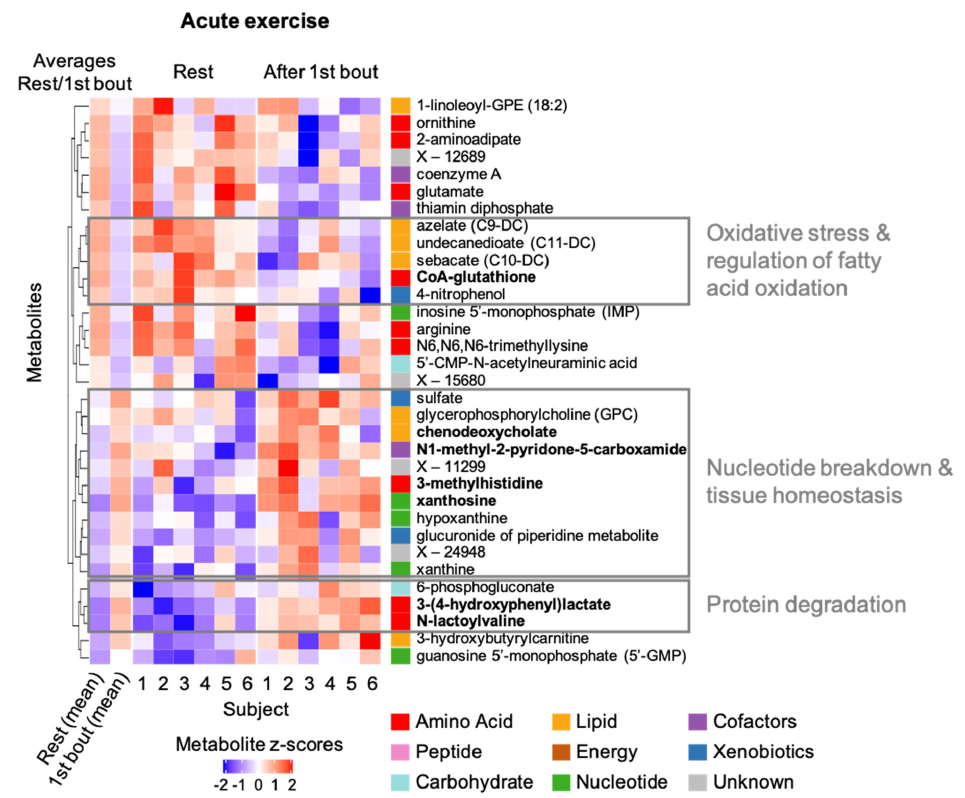
Figure 4. Heatmap of metabolites changing in response to acute exercise. Individual and average metabolite levels at rest and after the first bout of exercise are shown as z ‐ scores for all 33 metabolites with changes in response to acute exercise ( p < 0.05); red color indicates higher levels compared to all levels measured for the specific metabolite in the present study; analogously, blue color indicates lower levels; names of metabolites with significant changes after correcting for multiple testing are shown in bold. Metabolites were clustered by their similarity in metabolite levels at the two conditions across the participants; the resulting clusters are displayed in the dendrogram on the left of the heatmap. Selected clusters and their link to exercise ‐ related molecular processes are highlighted.